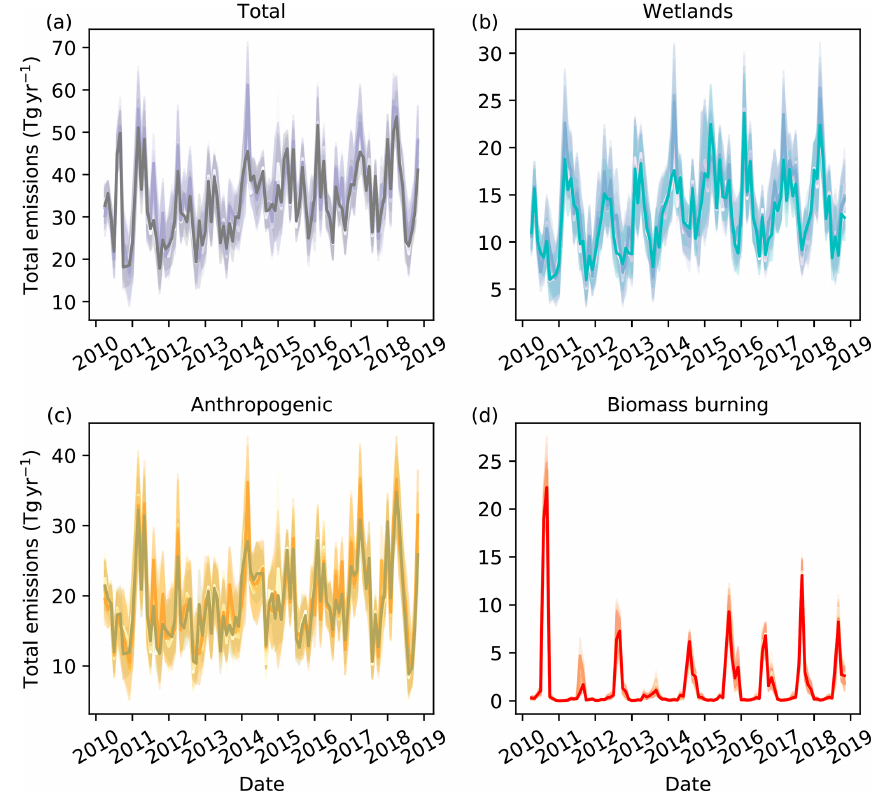
Figure 10. Brazil’s CH 4 emissions in a sensitivity inversion using 10 variants of GOSAT data generated with different model XCO 2 . All other components were held at the original configuration. Each line represents a different inversion run. (a) Total, (b) wetland, (c) anthropogenic and (d) biomass burning emissions. Prior emissions do not vary in this